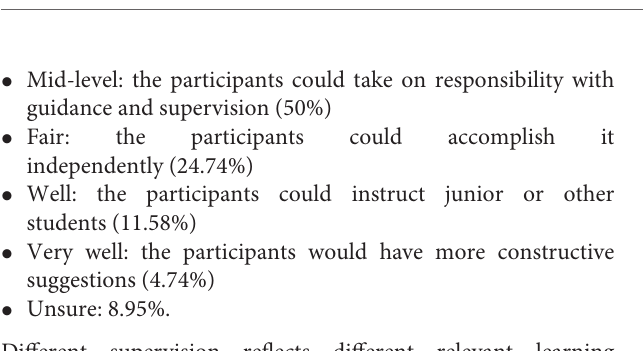
TABLE 2 | Task cognitive load distribution (from NASA scale) table. degree/percentage